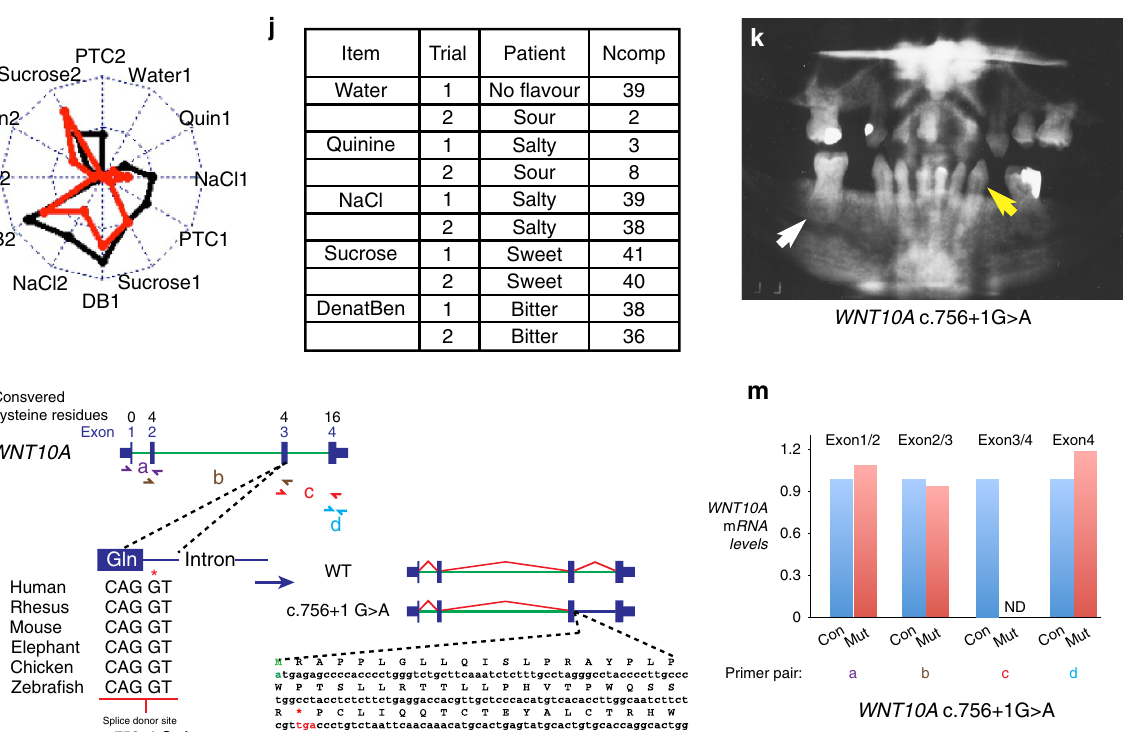
Figure 1 | Clinical features associated with human WNT10A mutation. ( a ) Thinning hair. ( b ) Nail dystrophy. ( c , d ) Fissures and scaling on palms and soles. ( e , f ) Starch-iodine sweat testing. Note brown grains on control palm indicating sweat production, and decreased sweating in patient (arrows). Insets show higher magnification of areas indicated by the lower arrow in each photograph. ( g , h ) Smooth tongue surface. ( i ) Taste testing. Patient data (red line) is similar to comparison group except for quinine and PTC1 (bitter). DB, denatonium benzoate (bitter). Higher y axis values indicate greater intensity (scale, 1–12). Patient was tested twice; 1 ¼ trial 1; 2 ¼ trial 2. ( j ) Taste quality assessment. NComp, number of comparison subjects ( N total ¼ 41) who gave same response as patient. ( k ) Oral X-ray. Note decreased alveolar bone density and tooth root and cusp defects. ( l ) Splice donor site mutation and predicted truncated protein. ( m ) qPCR with primers indicated in l confirms aberrant epithelial, and doxycycline (dox)-inducible epithelial mutants. compared with littermate controls (Supplementary Fig. 1a,b and Approximately 50% of Wnt10a (cid:2) / (cid:2) mice developed loosely Fig. 3a–c), consistent with a previous report 25 . Cusp and size anchored ectopic molar M4 teeth (Supplementary Fig. 1a,b). abnormalities were observed by E17.5 (Fig. 3d), indicating their Maxillary and mandibular molar teeth had flattened cusps, morphogenetic origin, and mimicked the effects of Wnt/ b - reduced size and defective root bifurcation and extension catenin inhibition after tooth initiation 20 . By 1 year of age,